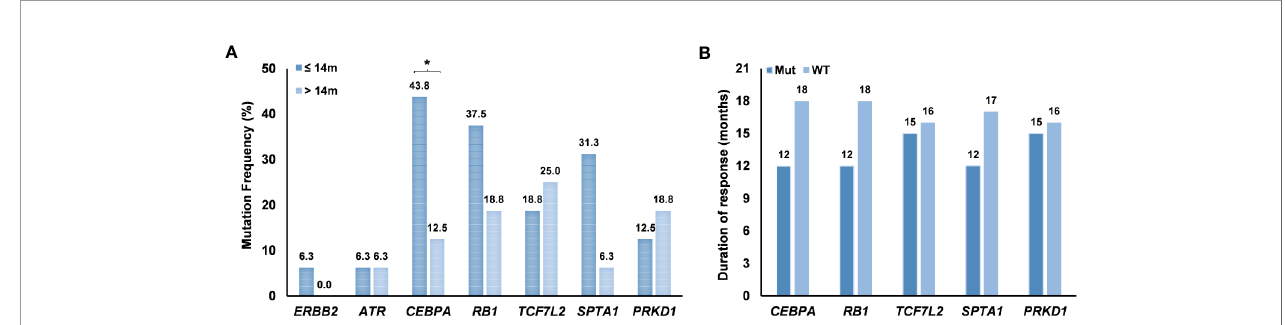
FIGURE 5 | Effect of mutated genes on the ef fi cacy of EGFR-TKIs. (A) Differences in mutation frequency of mutated genes between duration of response ≤ 14 months and duration of response > 14 months. (B) Duration of response to TKIs according to gene mutations. *P < 0.05. Mut, mutation; WT, wild